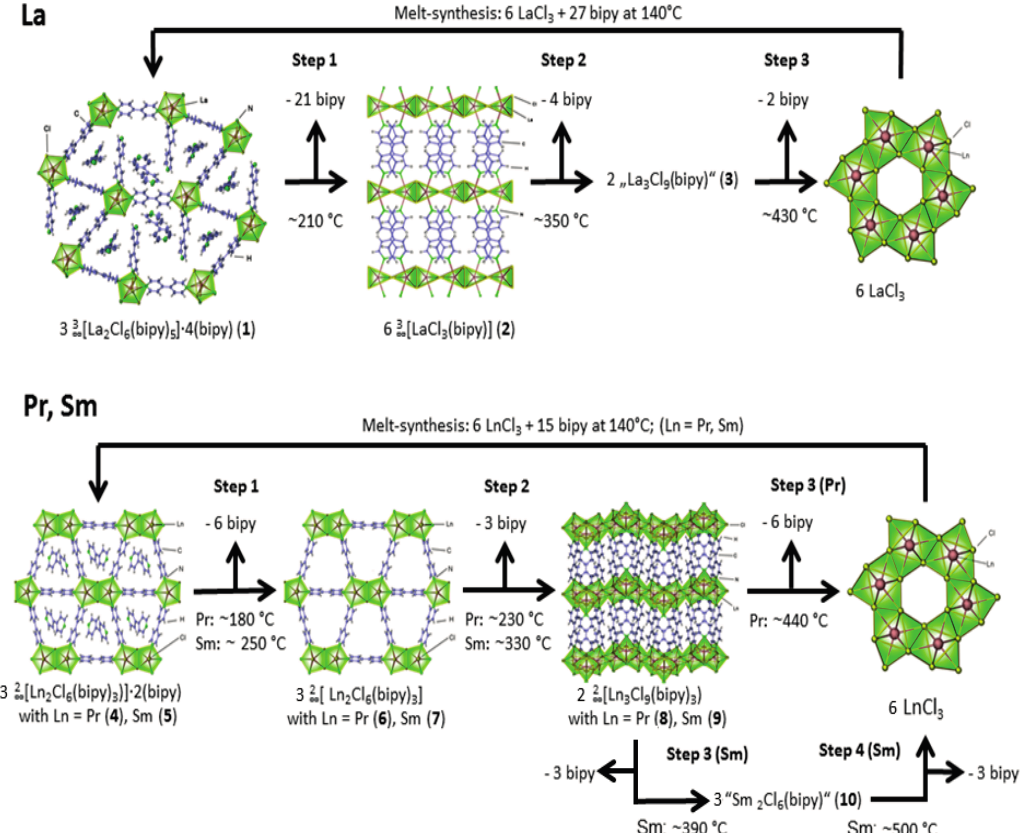
Figure 3. Depiction of the stepwise reaction and thermal condensation processes to new high temperature phases: 3 ∞ [La 2 Cl 6 (bipy) 5 ]·4bipy ( 1 ) via 3 ∞ [LaCl 3 (bipy)] ( 2 ) and “La 3 Cl 9 (bipy)” ( 3 ) to LaCl 3 ( top ); 2 ∞ [Pr 2 Cl 6 (bipy) 3 ]·2bipy ( 4 ) via 2 ∞ [Pr 2 Cl 6 (bipy) 3 ] ( 6 ) to 2 ∞ [Pr 3 Cl 9 (bipy) 3 ] ( 8 ) and PrCl 3 . 2 ∞ [Sm 2 Cl 6 (bipy) 3 ]·2bipy ( 5 ) via 2 ∞ [Sm 2 Cl 6 (bipy) 3 ] ( 7 ) to 2 ∞ [Sm 3 Cl 9 (bipy) 3 ] ( 9 ) followed by the yet structurally unidentified “Sm 2 Cl 6 (bipy)” ( 10 ) and SmCl 3 ( bottom ); see also Supporting